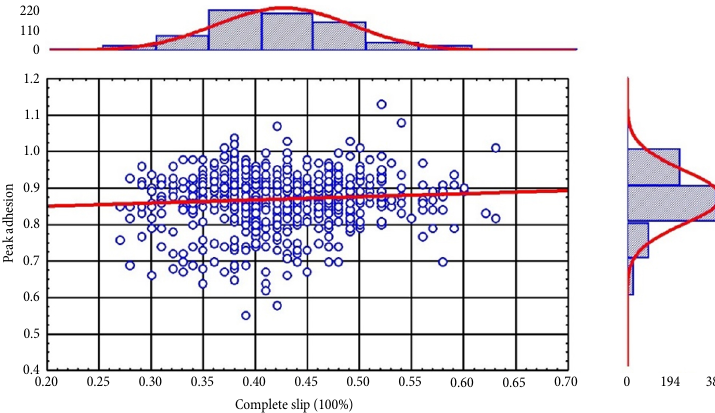
Fig. 14. Statistical distribution of interdependence between grip ratios m max / m 100%